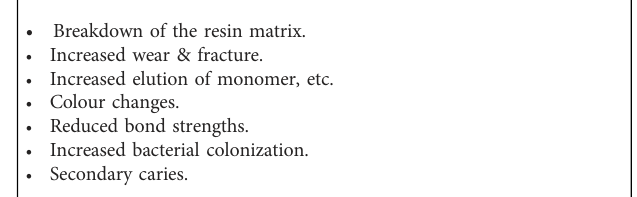
TABLE 1 Adverse consequences of under-cured resin